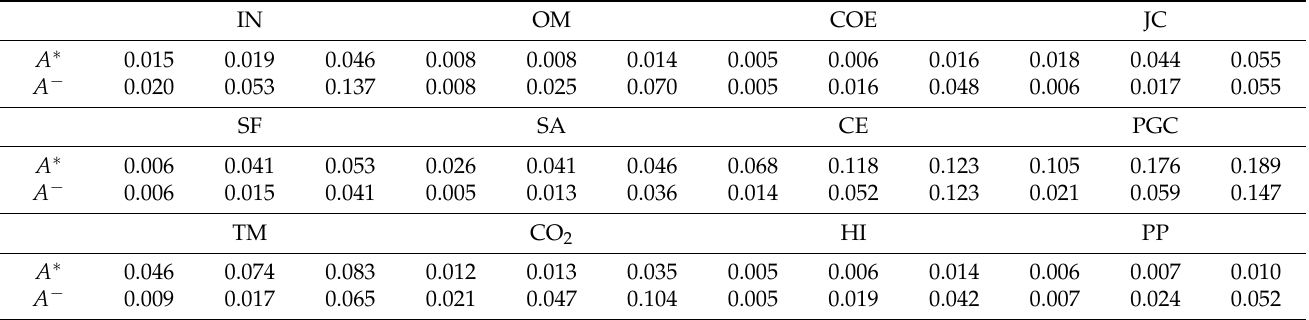
Table 9. Fuzzy Positive Ideal Solution (FPIS) and Fuzzy Negative Ideal Solution (FNIS).